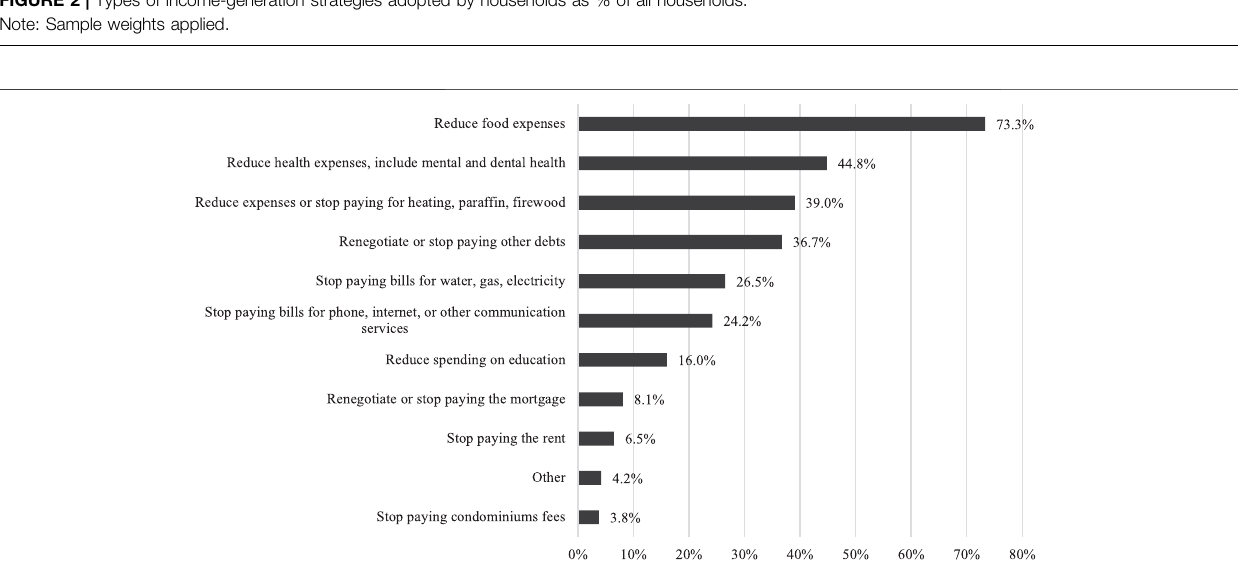
FIGURE 3 | Types of expenditure minimising strategies carried out by households as % of all households. Note: Sample weights applied.